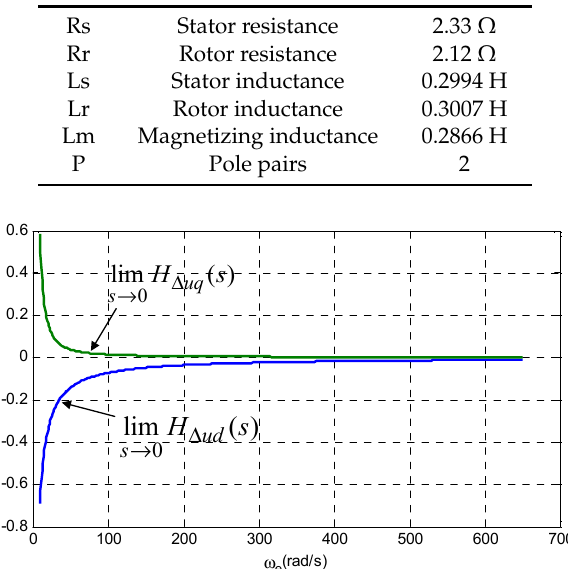
Figure 9. The amplitude of the transfer function of voltage error and observed speed.